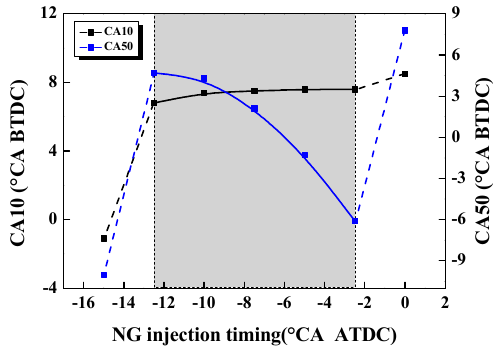
Figure 8. Changes in CA10 and CA50 and NG injection timing.